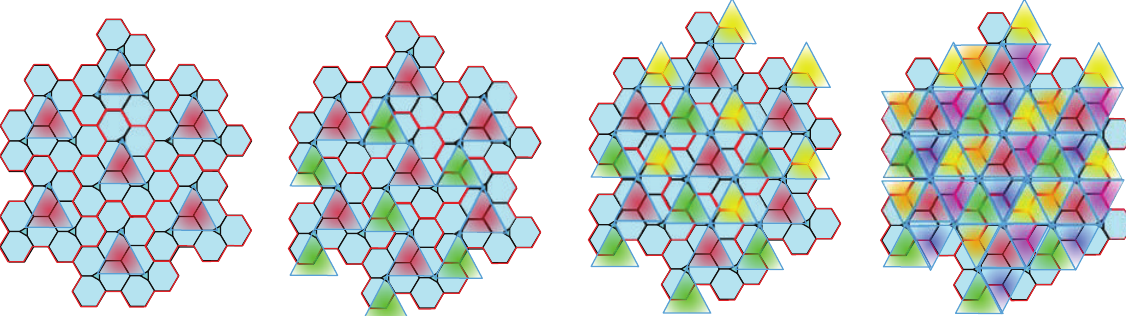
Figure 4: The basic clustering is illustrated on the most left picture. From left to the right, more and more cover shifts are added.